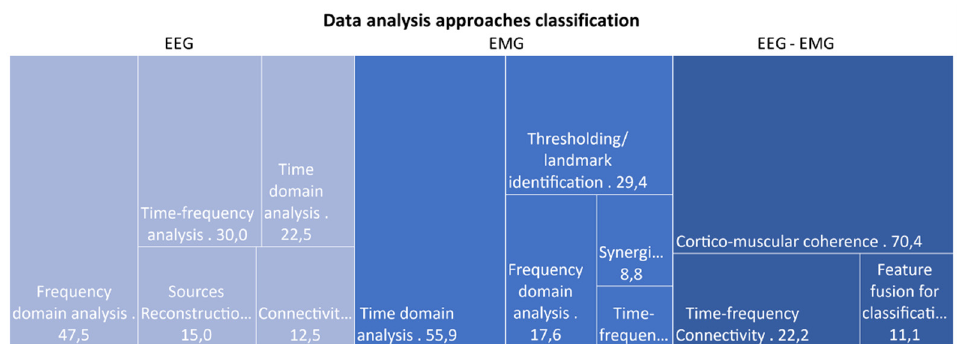
Figure 8. Graphical representation of data analysis approaches categories, divided according to the signal considered: only EEG, only EMG, or EEG and EMG combined. Percentage of papers using features belonging to each specific category are reported in the graph.